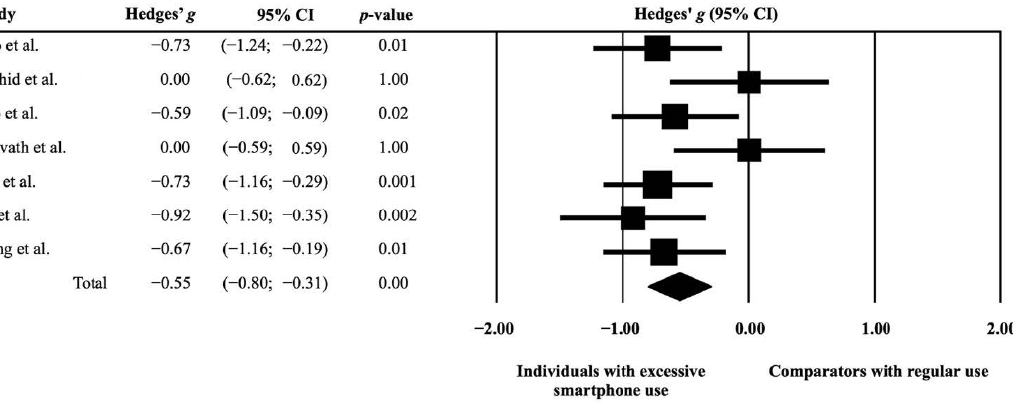
Figure 2. Forest plot comparing the effect sizes for brain volumes between individuals with excessive smartphone use and their comparators with regular use.